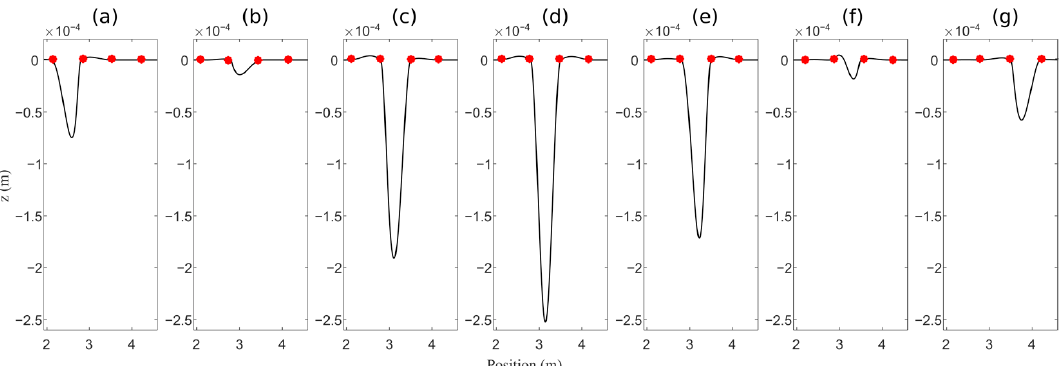
Figure 10. Evolution of the deflection of the rail in the vertical direction caused by the passage of the wheel. The red dots are the sleepers D4 to D7. ( a ) Passage between sleepers D4 and D5, ( b – f ) passage between sleepers D5 and D6 and ( g ) passage between sleepers D6 and D7.